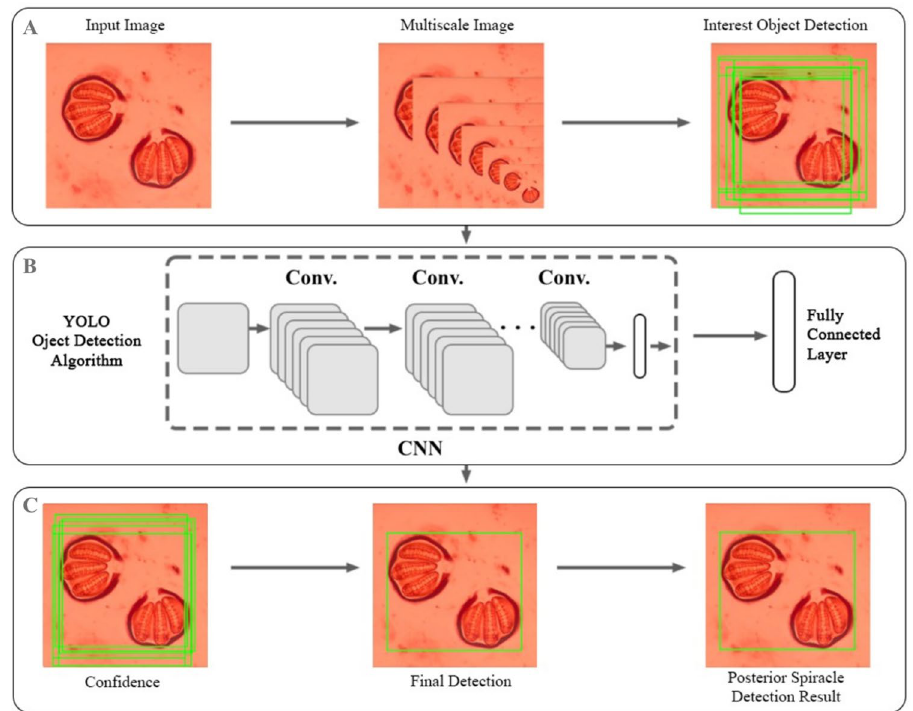
Figure 1. The processes of the custom object detection model used in this study was developed by using LabelImg program and YOLO object detection algorithm consisting 3 steps; ( A ) preparation process, ( B ) training process, and ( C ) detection